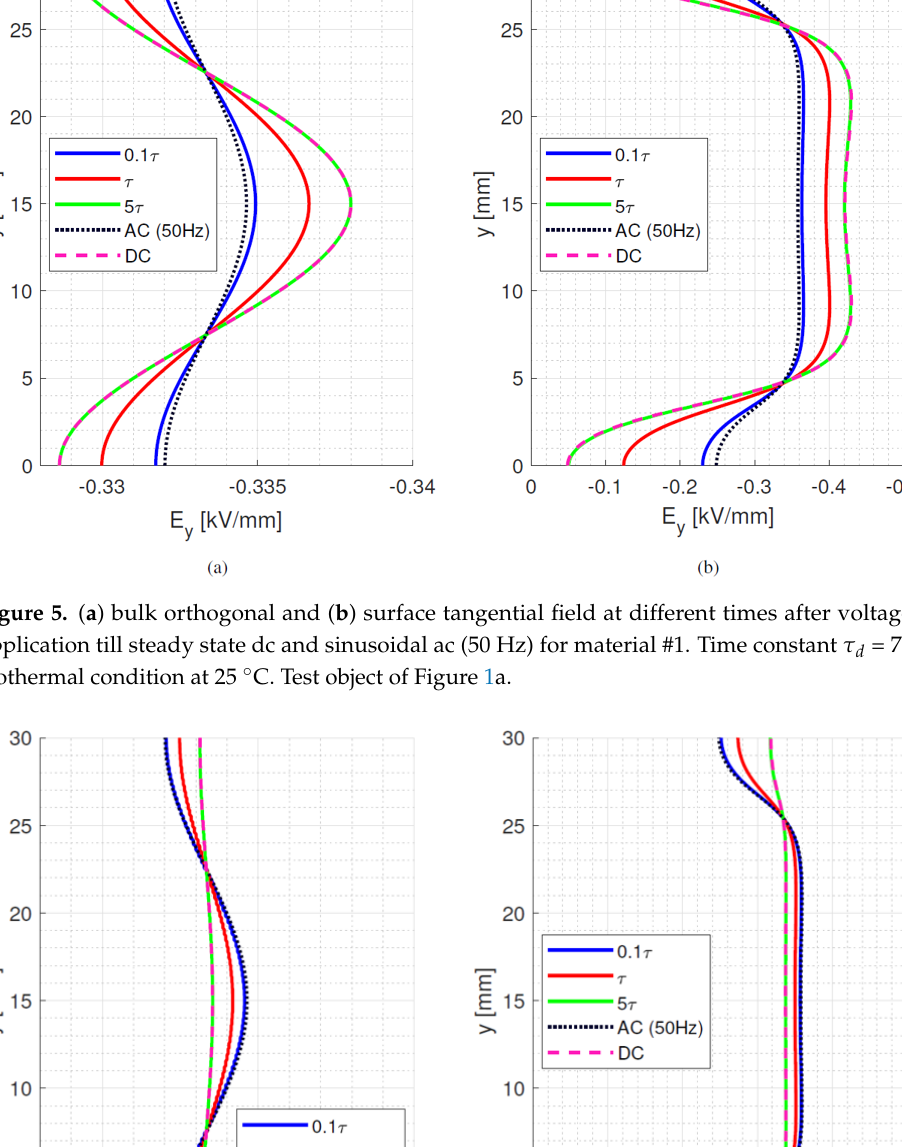
Figure 7. ( a ) bulk orthogonal and ( b ) surface tangential field at different times after voltage step application till steady state dc and sinusoidal ac (50 Hz) for material #3. Time constant τ d = 20 min. Isothermal condition at 25 °C. Test object of Figure 1a. This next section focuses on the bulk orthogonal field (which might be associated with internal partial discharges, in case of defects) and the tangential surface field, which is related to surface partial discharges and to design creepage. In addition to dc, steady